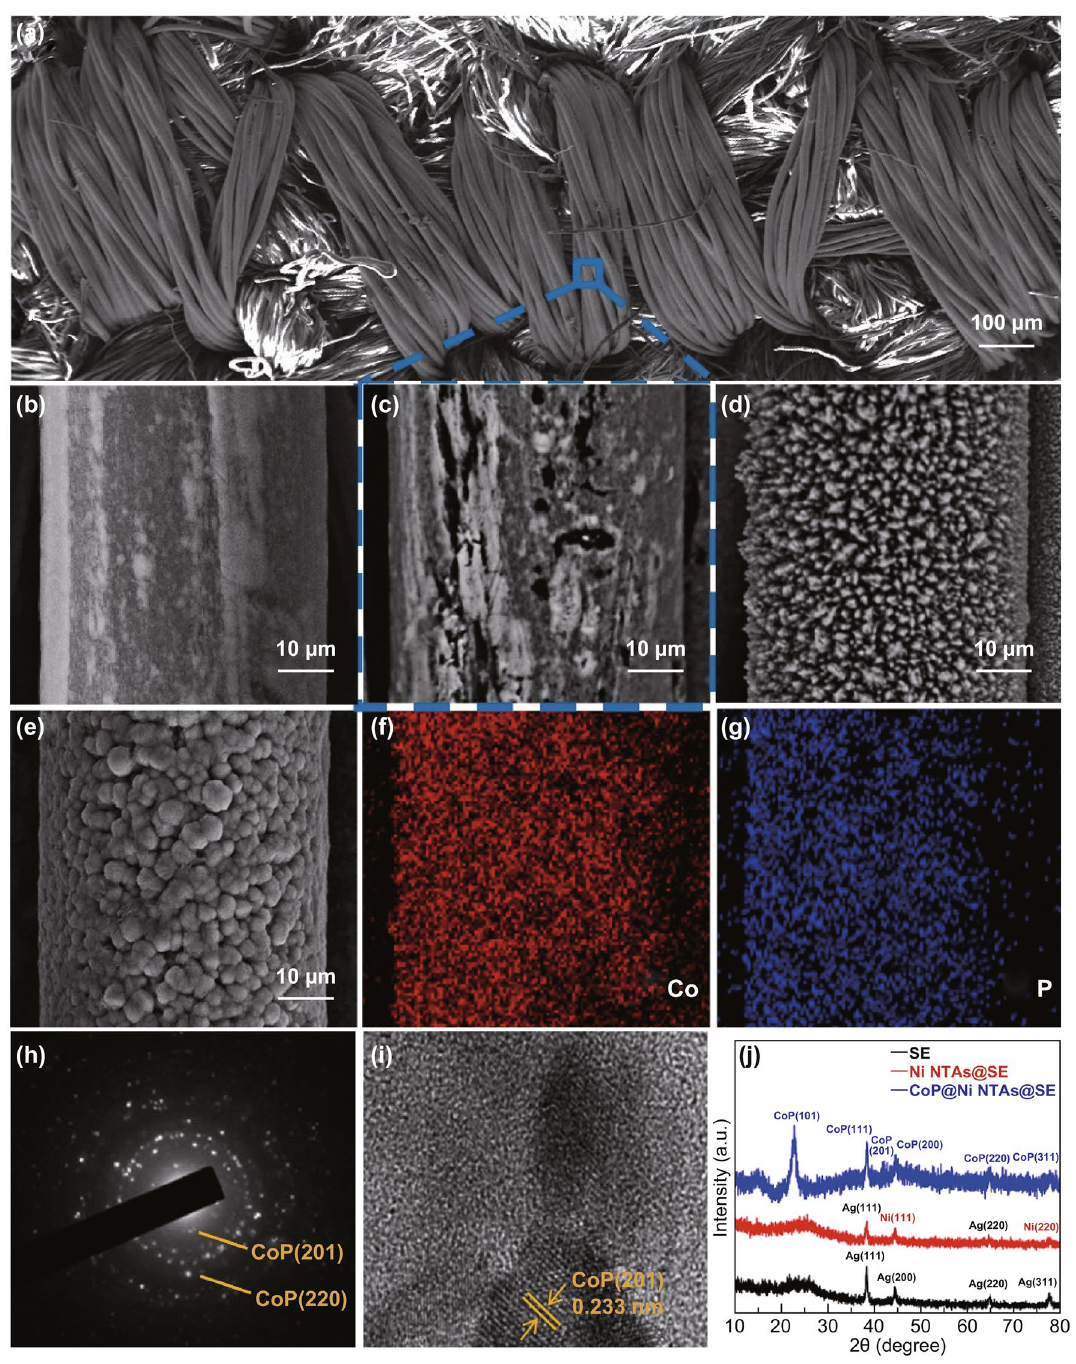
Fig. 2 a SEM images of the overview of the SE single finger. b A single fiber of the original SPNYs. c Damaged fiber surface of the